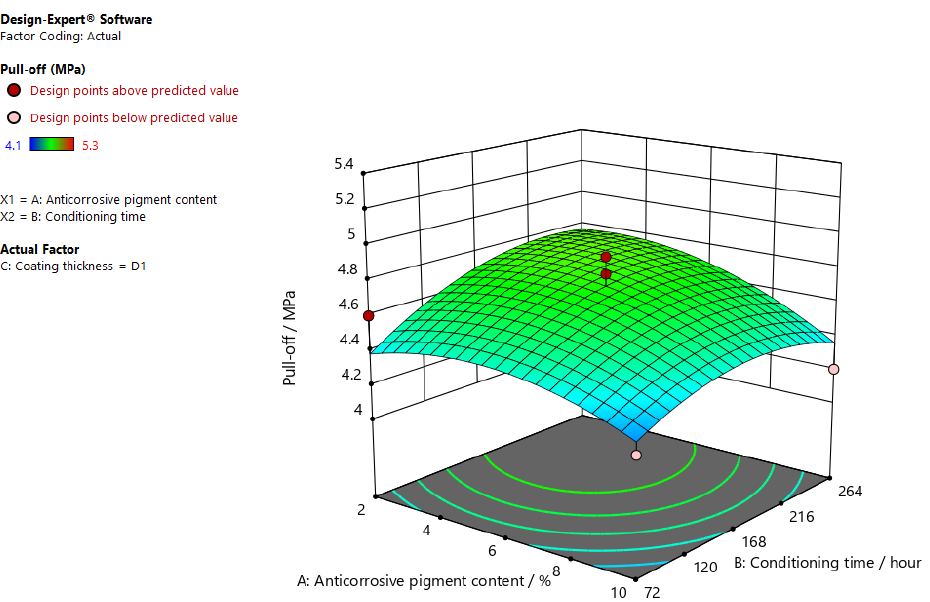
Figure 3. Response surface for regression model of the dependence of adhesion force (pull-off) between the applied coating and the substrate surface for the D1 coating thickness.